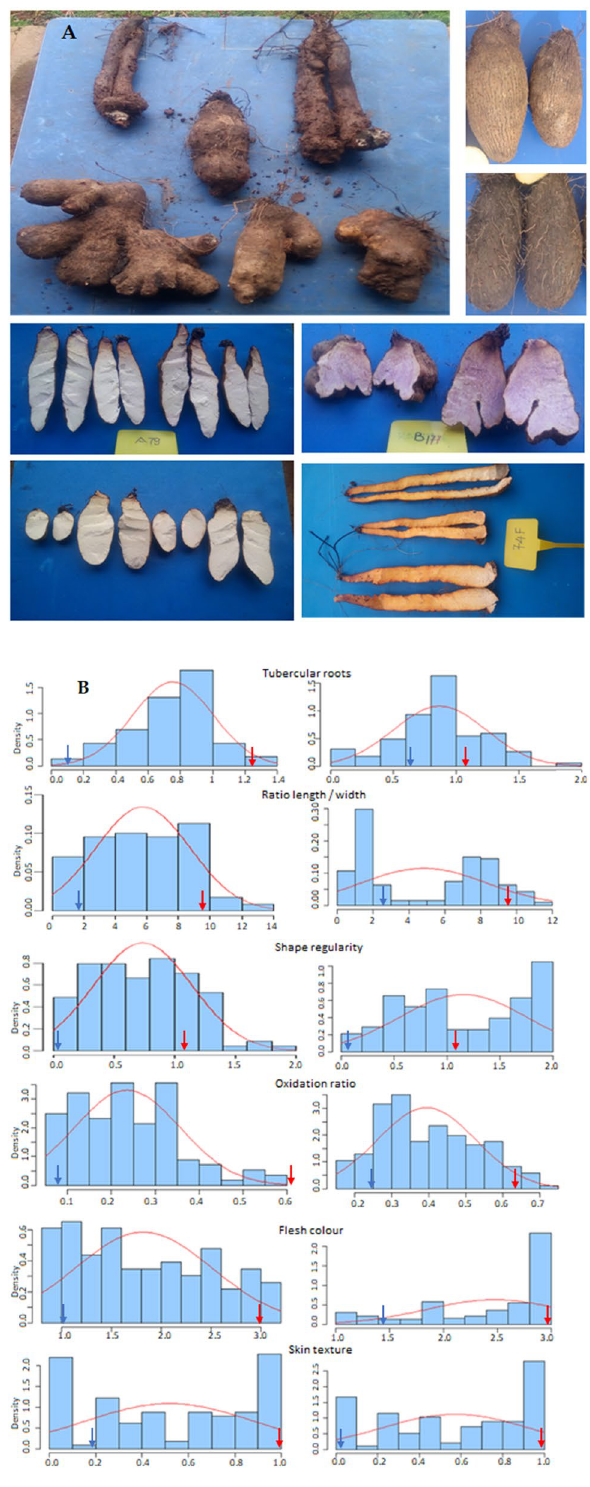
Figure 1. ( A ) Phenotypic variation for tuber shape, shape regularity, tubercular roots and flesh colour traits. ( B ) Phenotypic distribution of quality traits in population A (74F × Kabusa, on the left) and population B (74F × 14M, on the